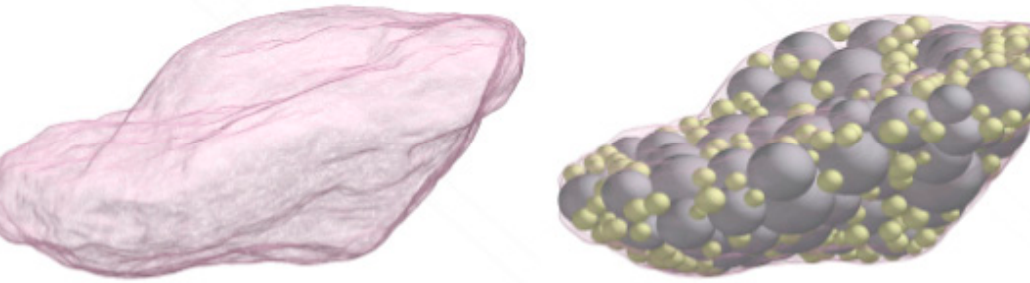
Figure 6. Three different packing types determined by different manners of particle size distributions. Figure 7. A 3D scanned rock model is used for forming breakage particles with real shape.